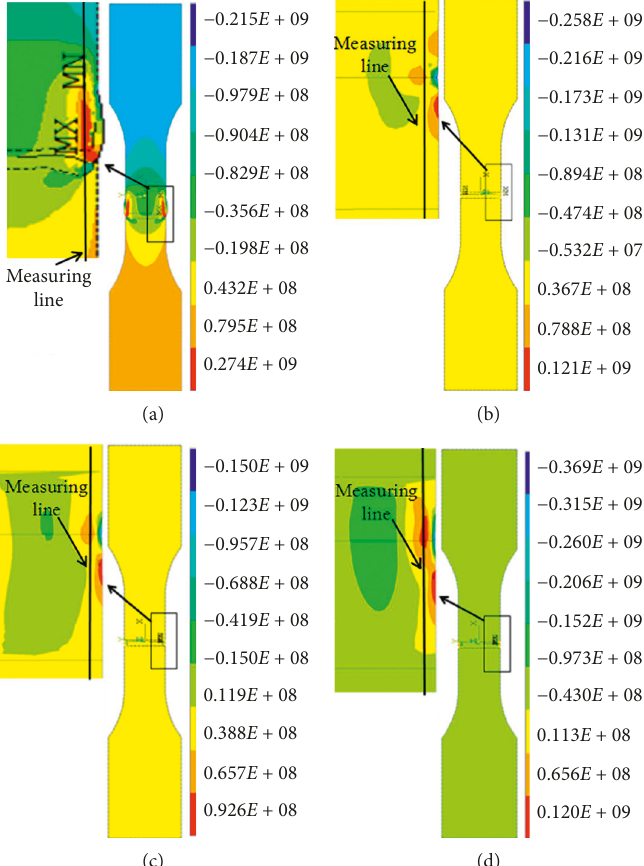
Figure 3: Results of simulations: (a) without annealing and annealing at 200 ° C (b), 250 ° C (c), and 300 ° C (d), previously presented in [20].